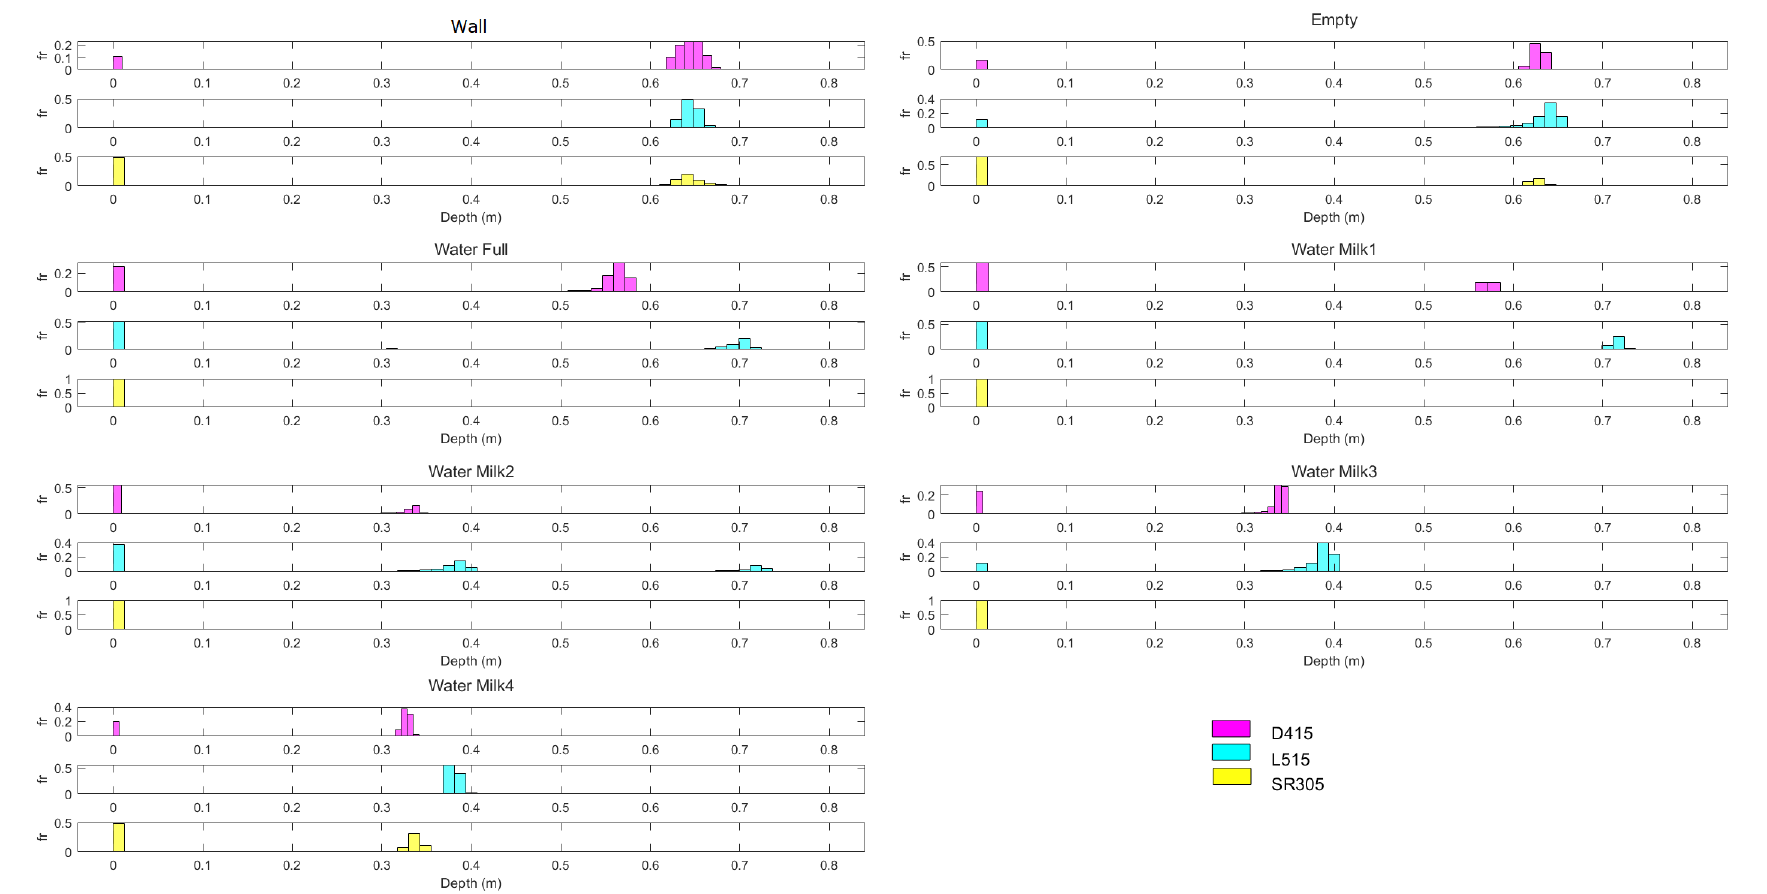
Figure 18. Histograms for each acquisition (allowing a comparison between cameras): each histogram represents the relative frequency for each average depth value estimated by each